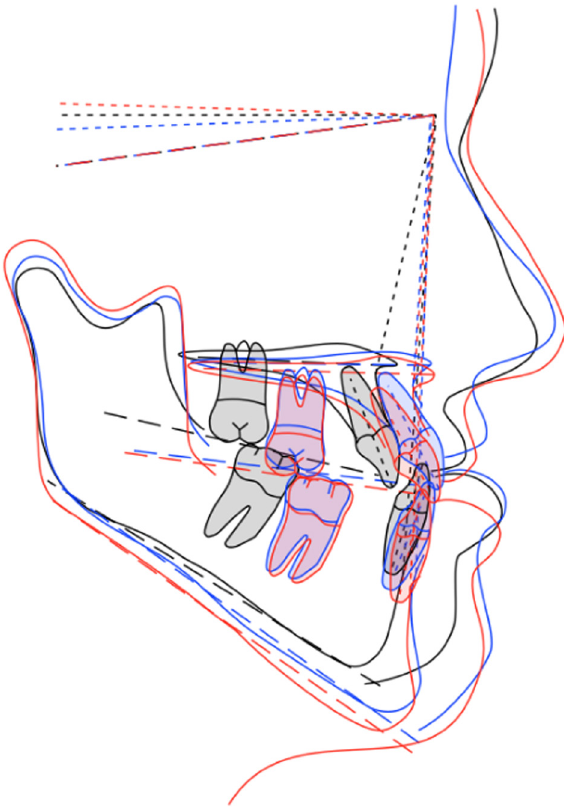
Figure 8. Superimposition of initial (1991; black), post treatment (1996; blue) and Twenty-four year retention (2020; red) on